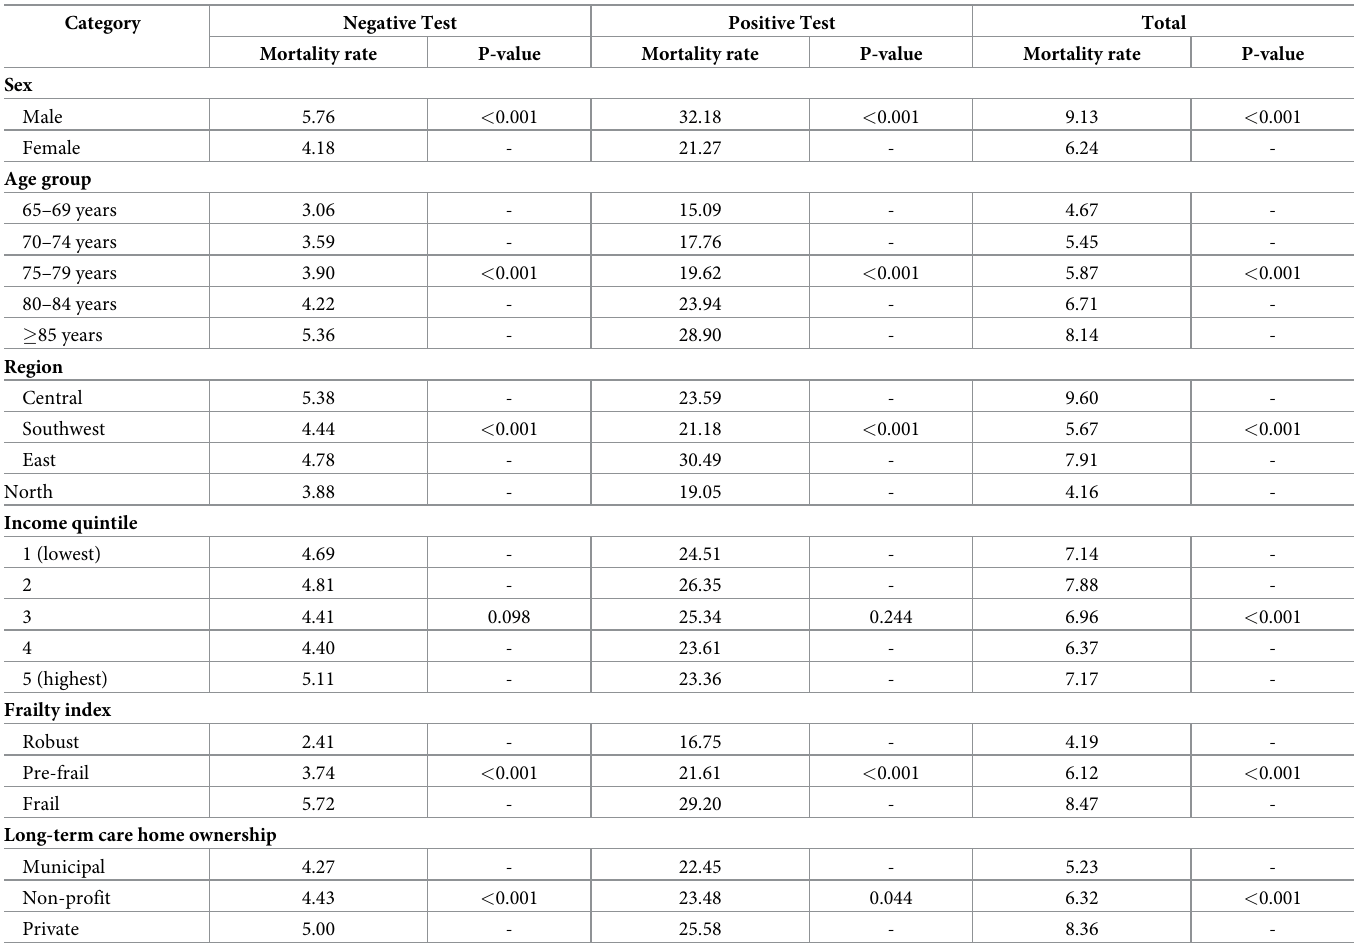
Table 2. Mortality rate (%) based on COVID-19 tests and demographics for March 2020 to December